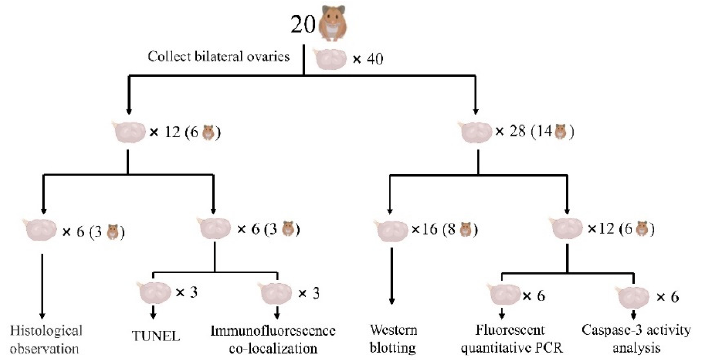
Figure 1. Ovarian experiment design. Note, the SD group was taken as an example.